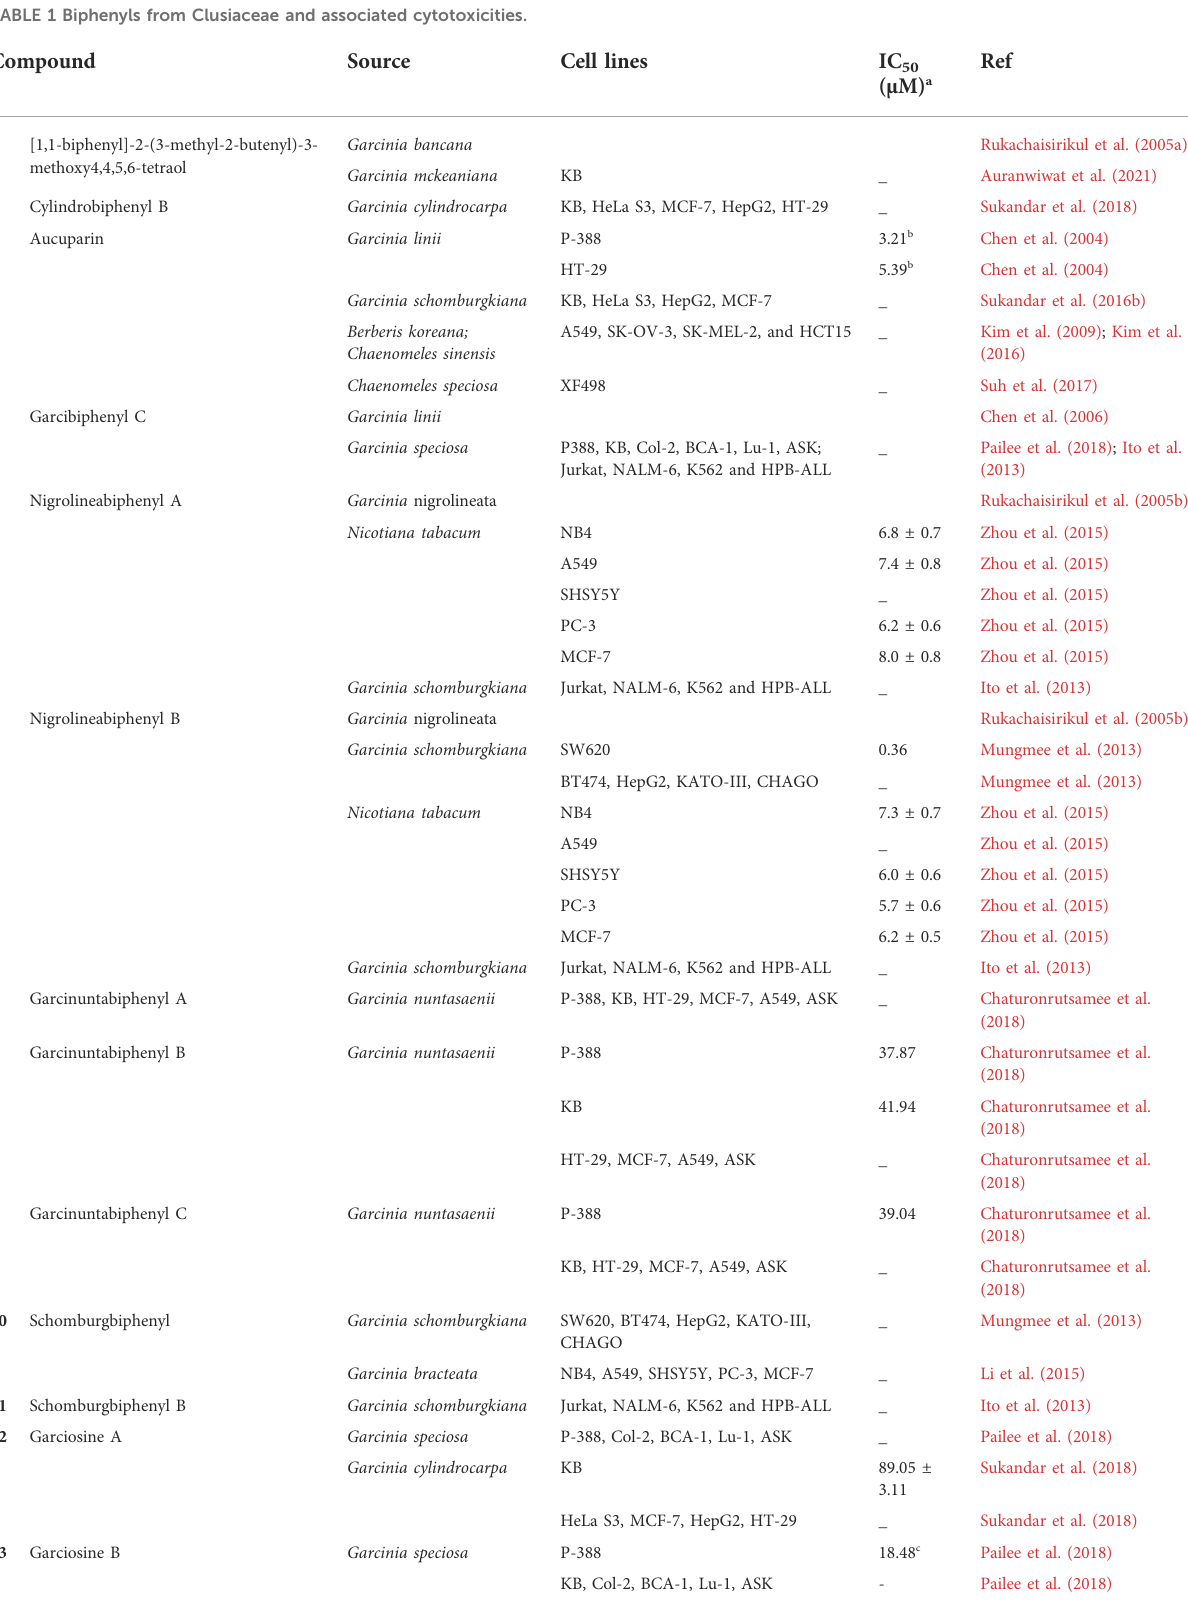
TABLE 1 Biphenyls from Clusiaceae and associated